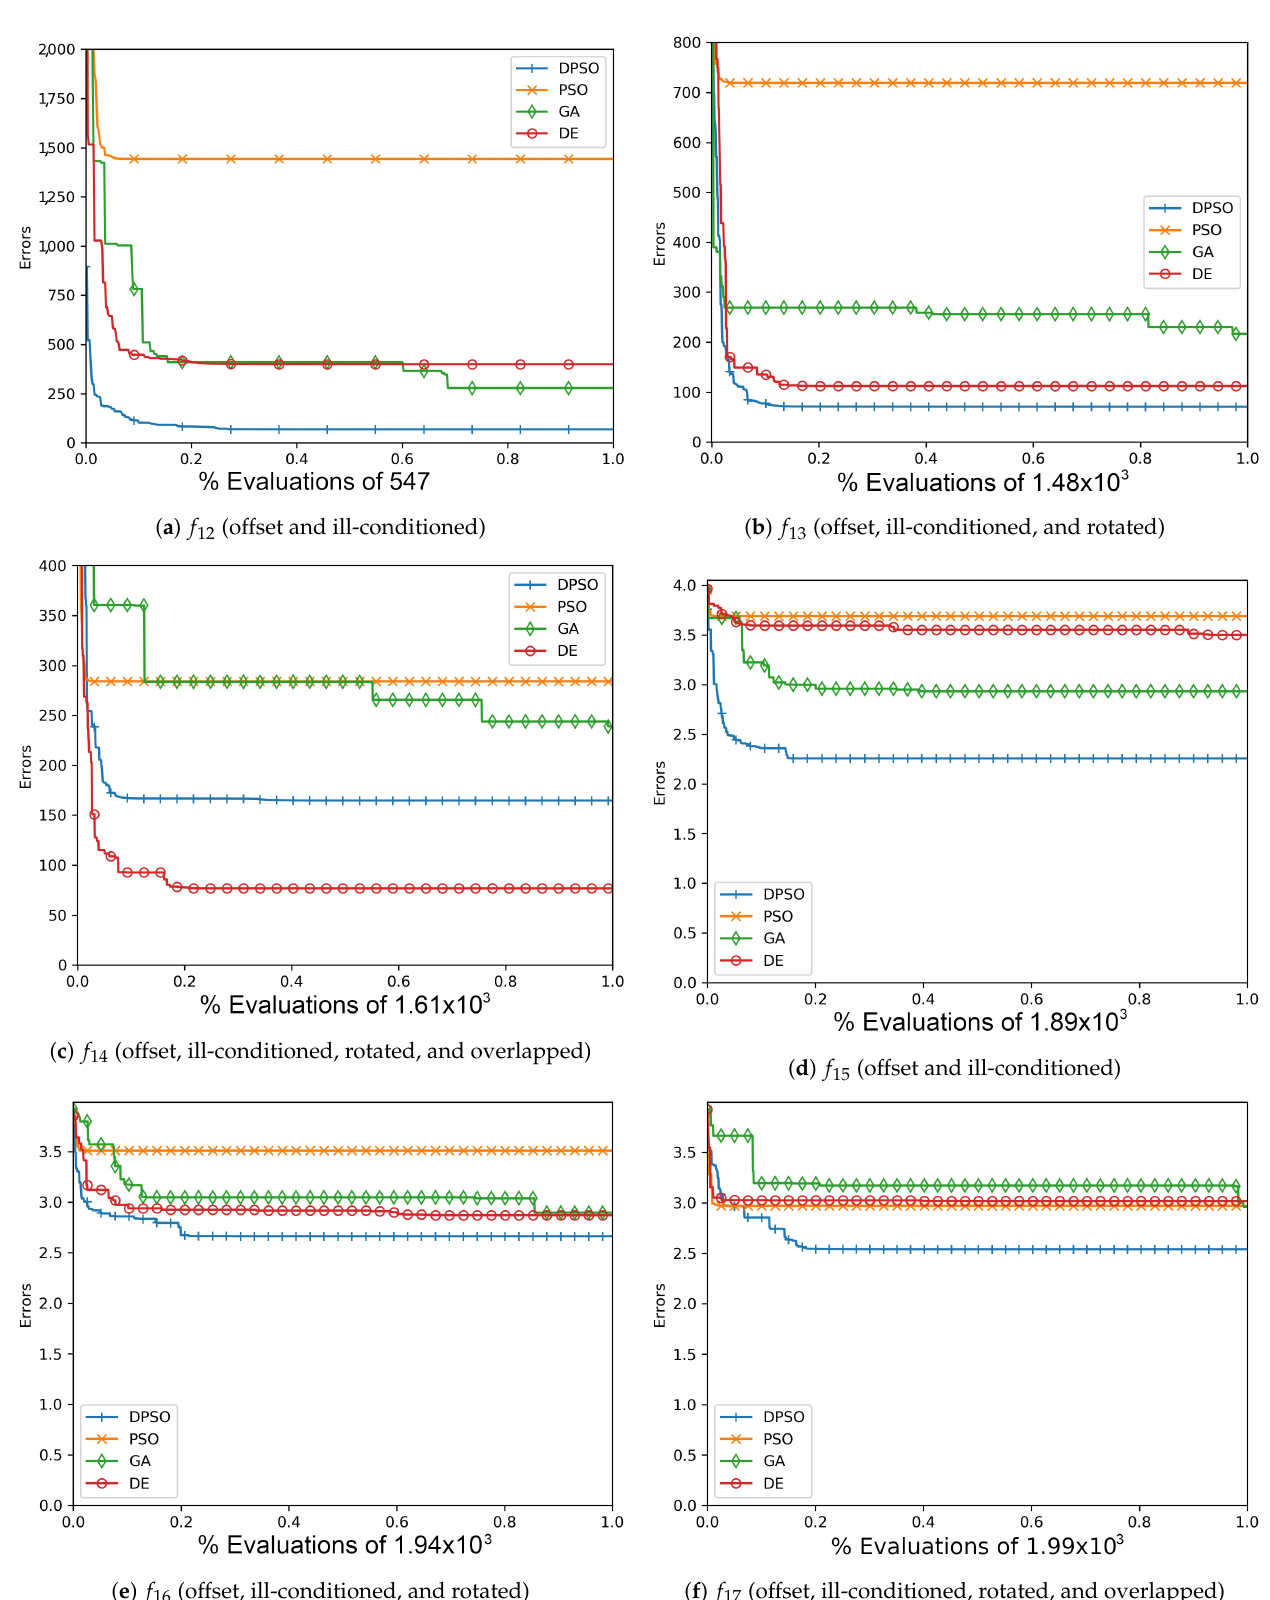
Figure A8. The average Rastrigin ( f 12 , f 13 , f 14 ) and Drop-Wave ( f 15 , f 16 , f 17 ) global best results over time for 14